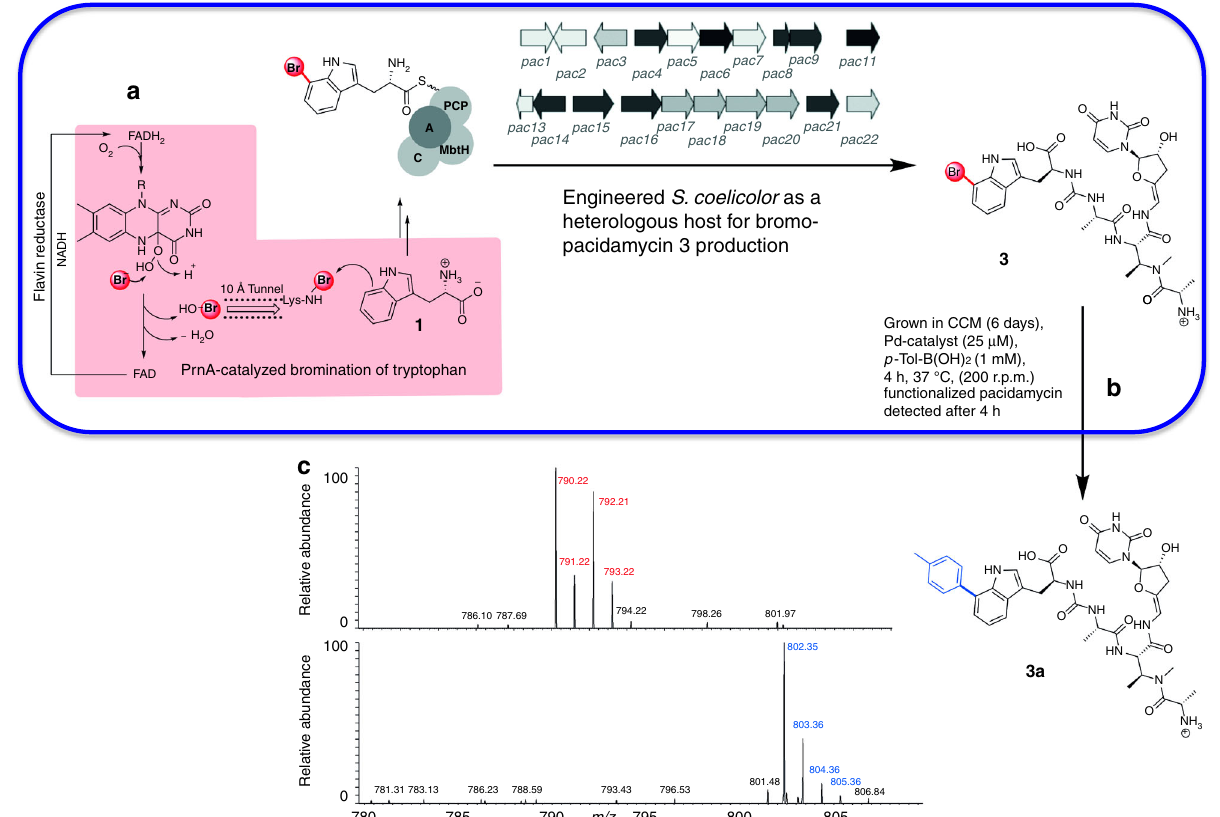
Fig. 6 In culture biosynthesis and cross-coupling of Br-pacidamycin-D. a S. coelicolor M1154 engineered to express the tryptophan 7-halogenase gene ( prnA ) and the entire pacidamycin gene cluster ( pac1 – pac22 ), which encodes the non-ribosomal peptide template/thiol tethered biosynthesis of pacidamycin ( S. coelicolor RG-1104). b Cross-coupling of the Br-pacidamycin D 3 produced by the living culture. c Extracted Ion Chromatograms of Br-pacidamycin D 3 and the cross-coupled product p- tolyl-pacidamycin D 3a . This system exempli fi es that this chemistry is not only compatible with less robust living cells but also that it is compatible with the very high dilutions and low titers that many natural products are present at. The engineering of bromo-metabolite production enables this exciting advance. Furthermore, the use of this model system exempli fi es that the chemistry is compatible with both peptides and